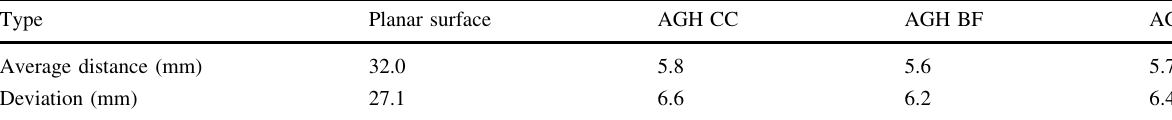
Table 6 Deviation of the planar and NURBS surfaces from the point cloud (AGH) Type